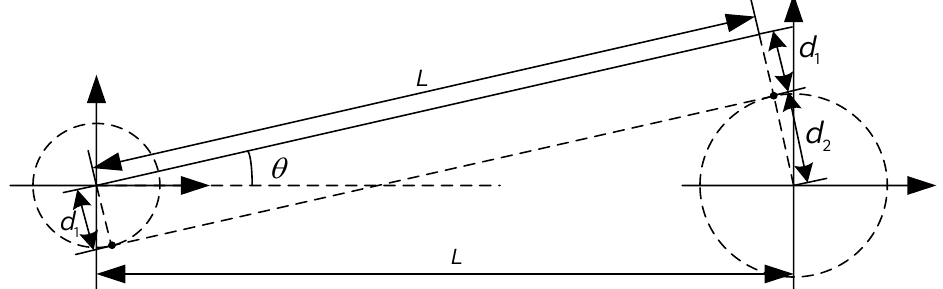
Figure 15. Relationship between offset and Angle of machine.